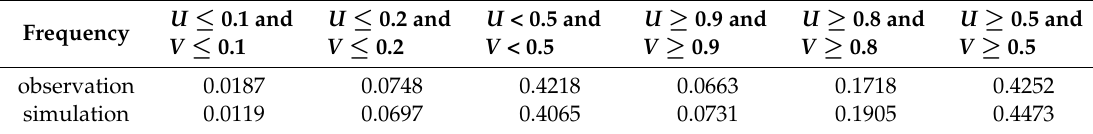
Table 2. The frequency statistics of observed and simulated data points in different regions.